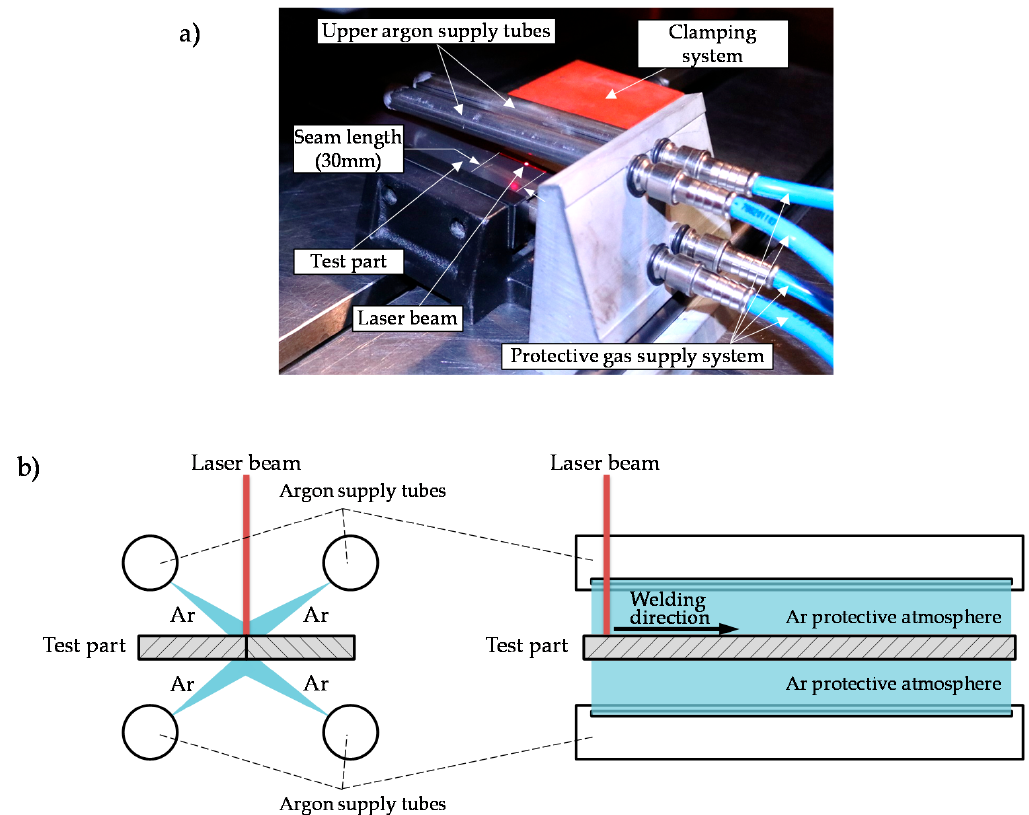
Figure 8. ( a ) Experimental setup for ensuring the protective atmosphere during the laser beam welding (LBW) tests; ( b ) Frontal and lateral schematic views.